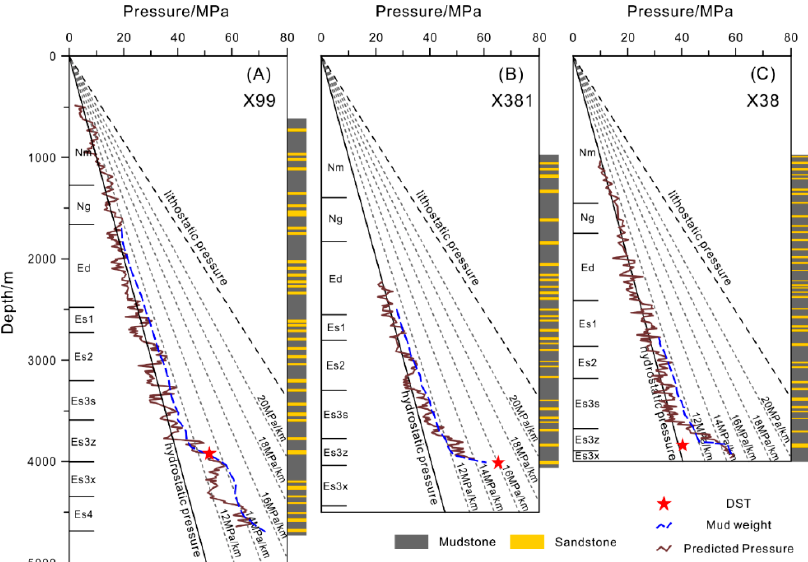
Figure 8. Relationship between the estimated pressure in mudstone and the measured pressure in the reservoir. The columns of lithology are also showed on the right of the well. ( A ) The pressure in the sandstone is equal to that in the mudstone in well X99; ( B ) the pressure in the sandstone is higher than that in the mudstone in well X381; ( C ) the pressure in the sandstone is lower than that in the mudstone in well X38. The well locations are shown in Figure